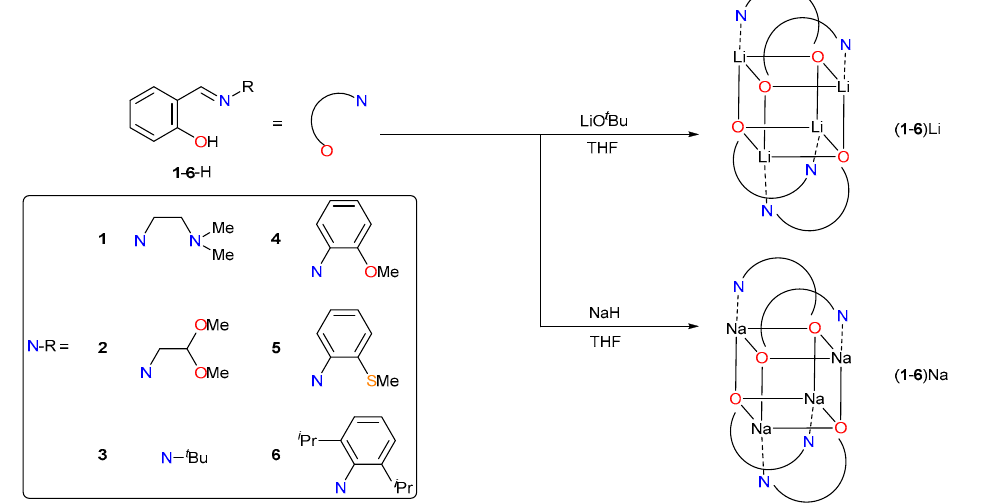
Table 1. ROP of L -lactide catalyzed by Li- and Na- complexes of 1–6 [22] .